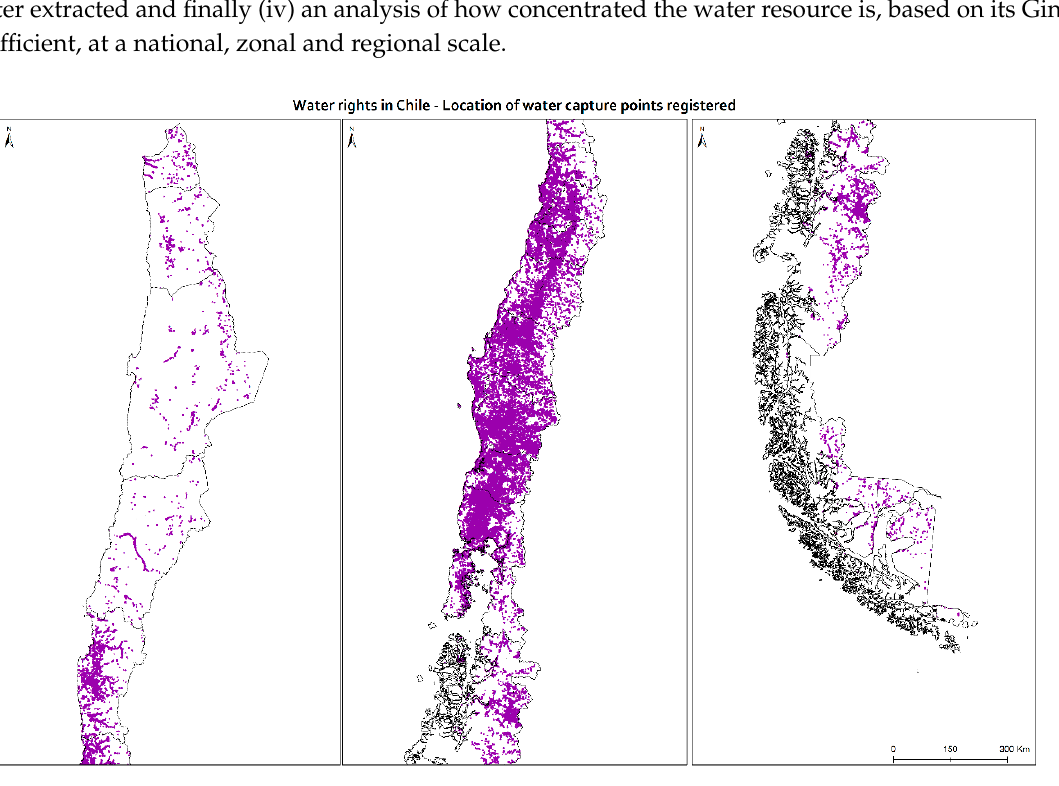
Figure 1. Location of water capture points registered as rights at the General Water Directorate of the Ministry of Public Works. Source: drawn up by the authors based on data from the Dirección General de Aguas (DGA).